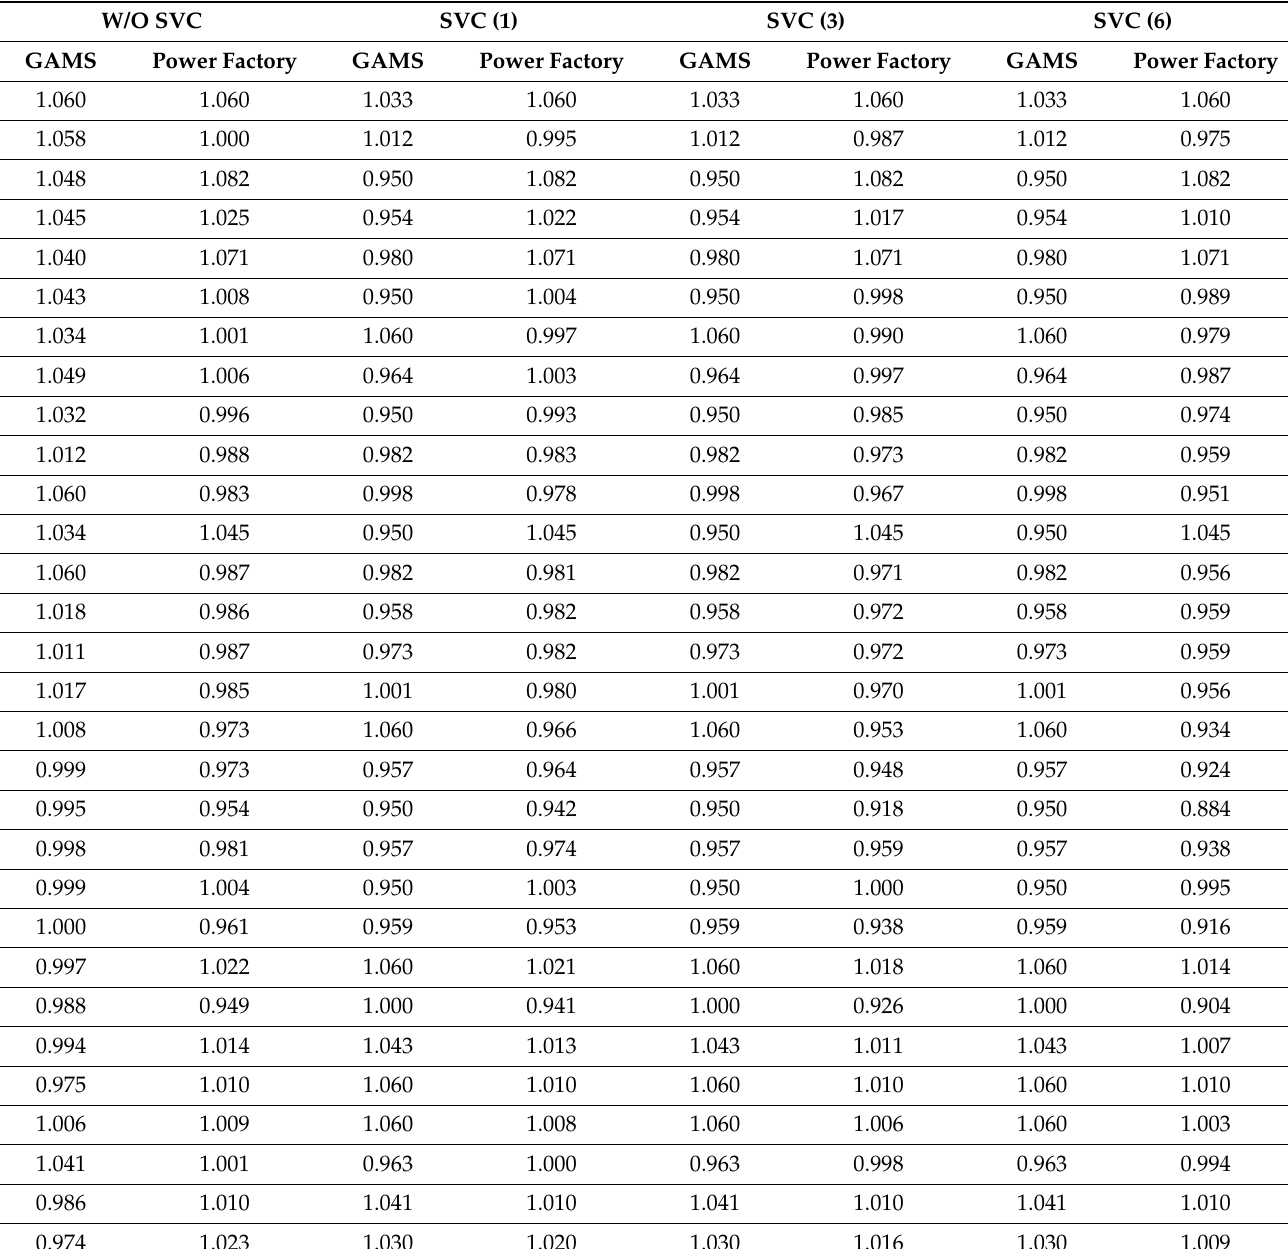
Table 4. Comparison of the voltage profile in the 30-node scheme. GAMS vs Power